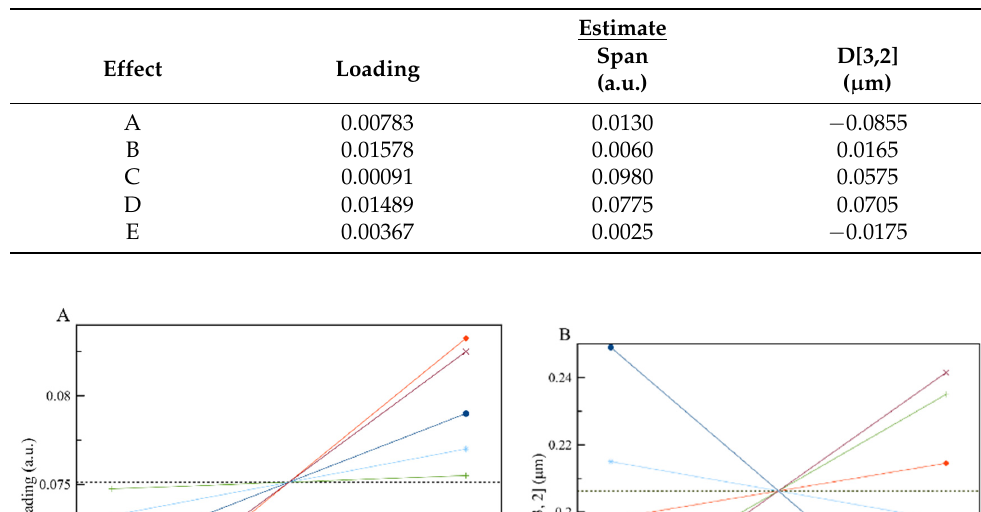
Table 4. Selected values based on the FFD, along with the properties of the synthesized nanoparti- cles.